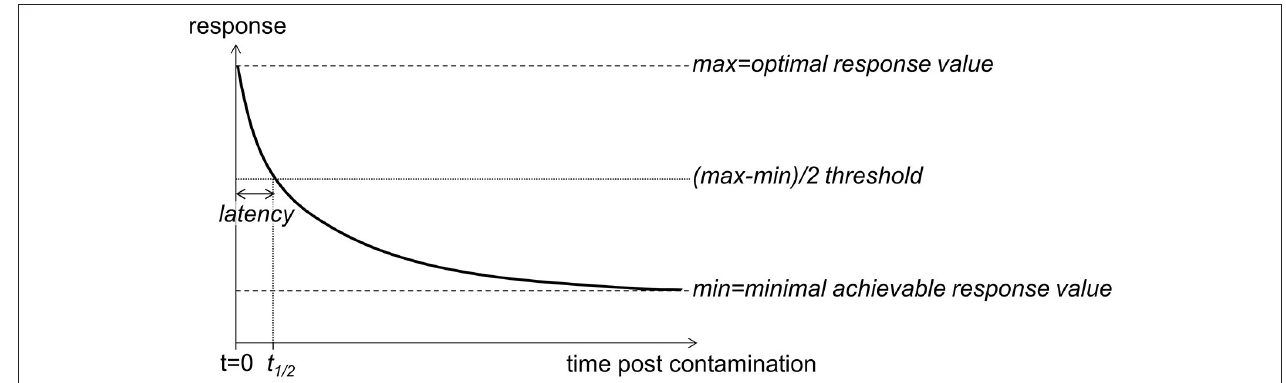
FIGURE 1 | Schematic representation of the time-response (here, ϕ PSII) relationship expected to occur following PSII inhibitor exposure (contamination on t = 0). ϕ PSII is anticipated to decrease after herbicide exposure, from its optimal value to a minimal achievable value (maximal inhibition). The latency is defined as the time the PSII inhibitor takes to cause a 50% inhibition of the response. All the toxicological values are susceptible to change depending on the concentration of